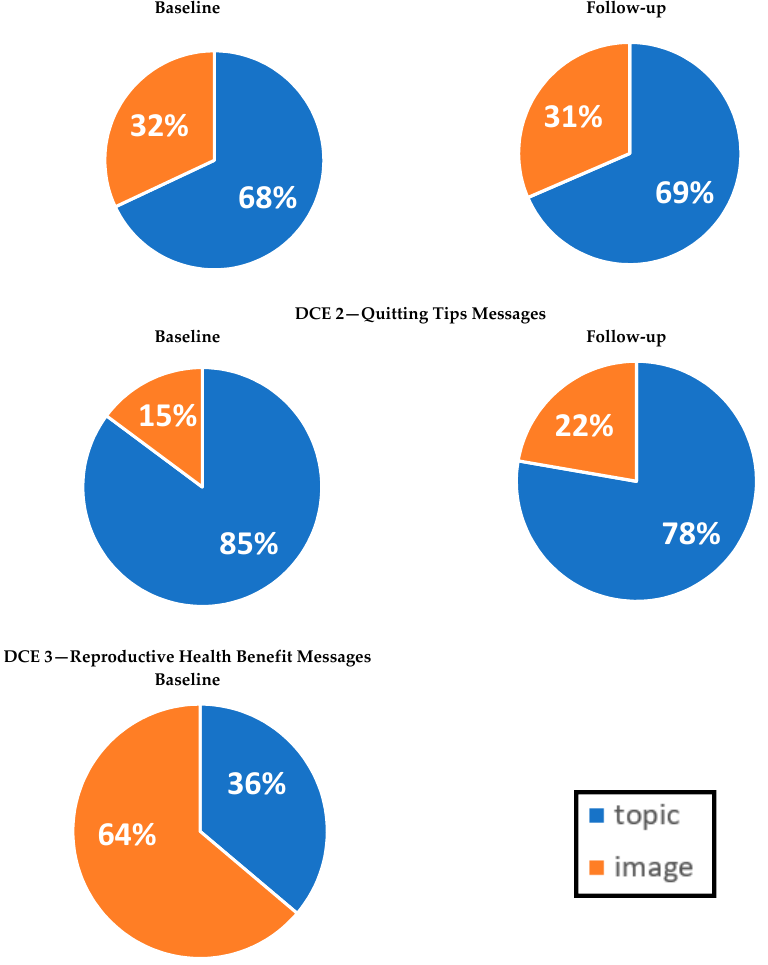
Figure 5. Relative importance * of attributes on choice of insert (* Relative importance was calculated using a utility range (i.e., the difference between each characteristic’s highest and lowest estimated part-worth utility or estimated effect on choices), divided by the sum of all the characteristics’ utility ranges for a given outcome. DCE 3 was conducted only at